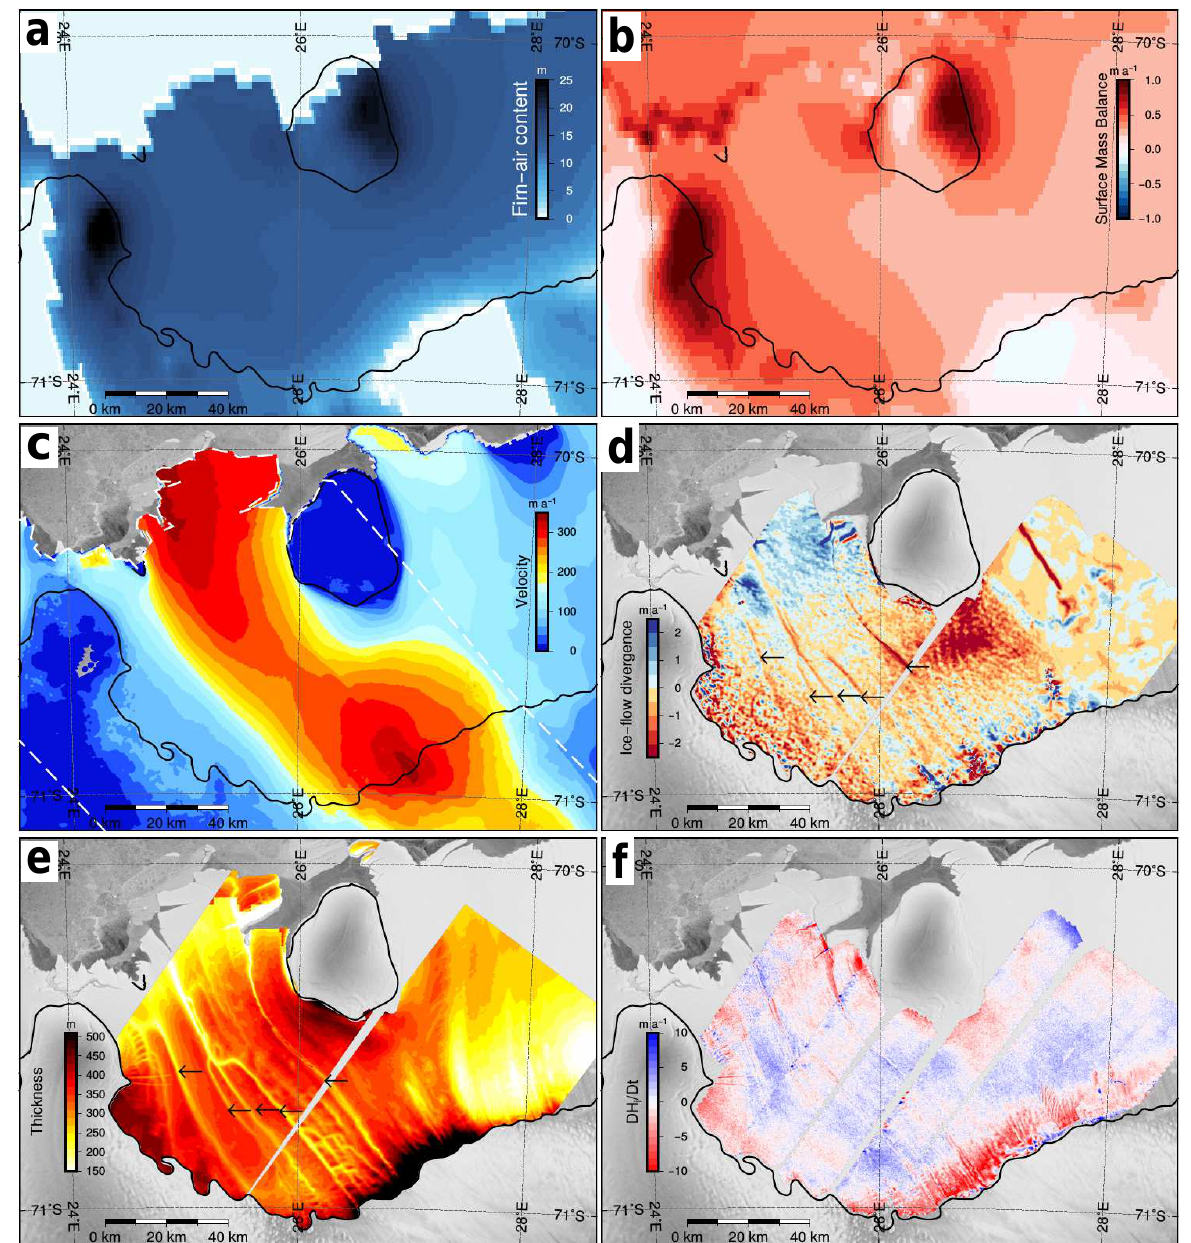
Figure 2. (a, c, e) Variables entering Eqs. (1) and (2) and (b, d, f) terms needed to calculate the LBMB in Eq. (1). (a) Firn air content ( H a ), (b) surface mass balance ( ˙ M s ), (c) surface velocities ( u ) (the white dashed line delineates the flow field from Berger et al. (2016)), (d) ice flow divergence ( H i ( ∇ · u ) ) (note that the red band 30km east of Derwael ice rise is caused by a seam in the flow field of Rignot et al., 2011b), (e) hydrostatic ice thickness of 2014 ( H i ) and (f) Lagrangian thickness change (D H i / D t ). Arrows in panels (d) and (e) locate ice shelf channels. The background is from the Radarsat mosaic (Jezek and RAMP Product Team, 2002) and the black line delineates the grounding line (Depoorter et al., 2013b). Key features regarding the input datasets are summarized in Table 1.